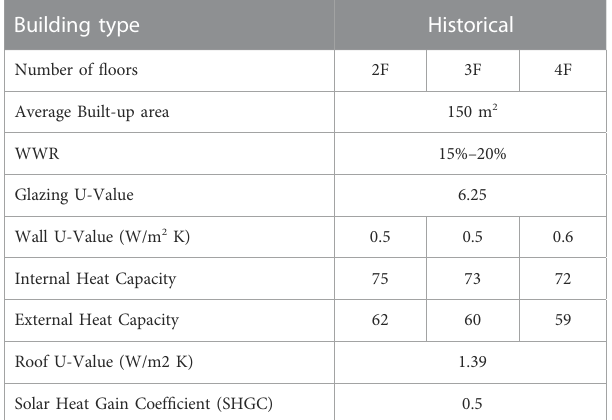
TABLE 3 Construction material characteristics for historical archetypes in Al Darb